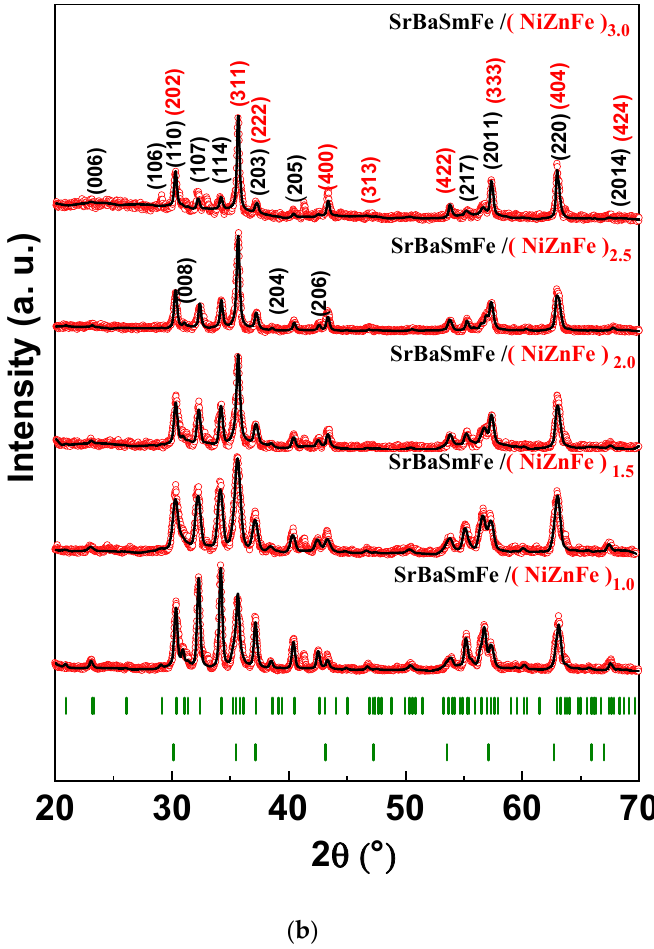
Figure 2. XRD powder patterns of ( a ) pure SrBaSmFe, NiZnFe, and ( b ) SrBaSmFe/(NiZnFe) x hard/soft ferrite nanocomposites (1 ≤ x ≤ 3).